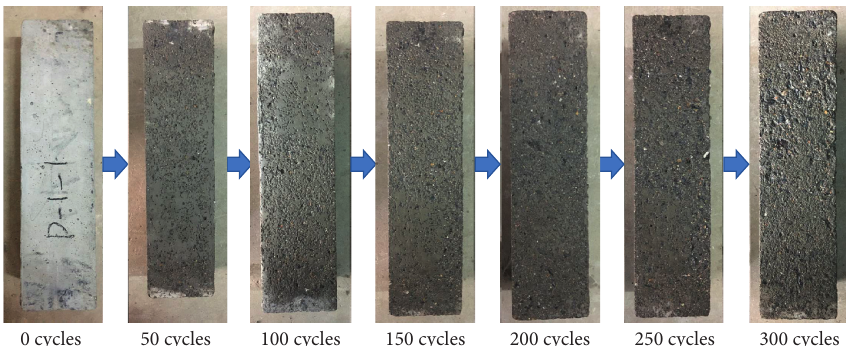
Figure 2: OCC-1 surface morphology after the freeze-thaw cycle.